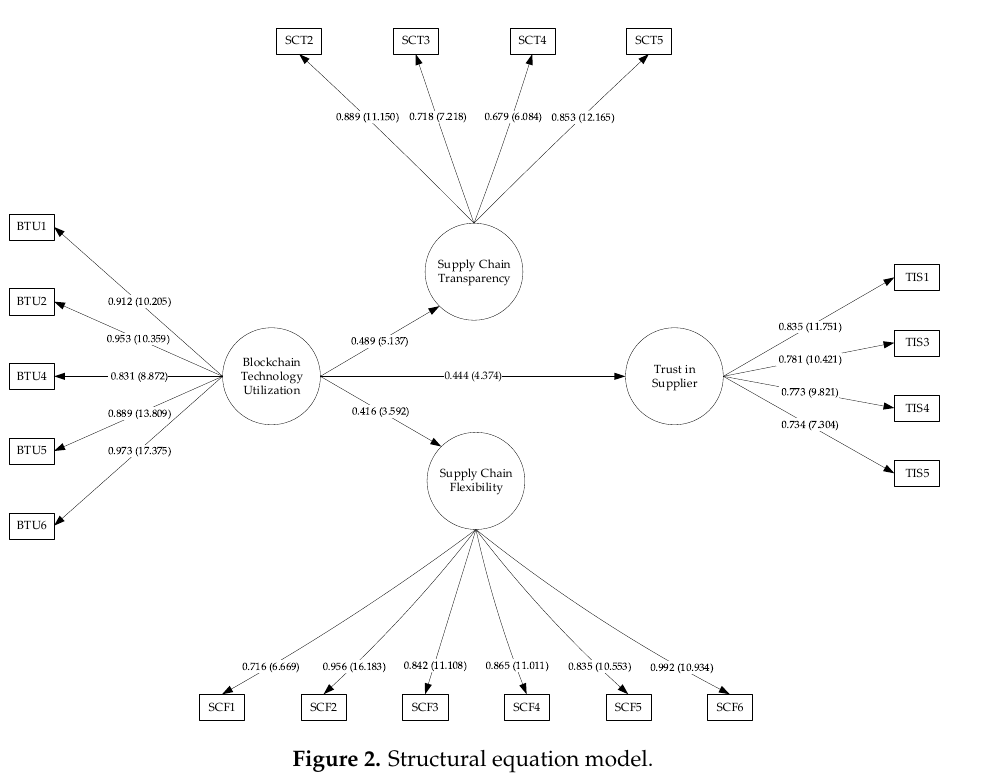
Figure 2. Structural equation model.